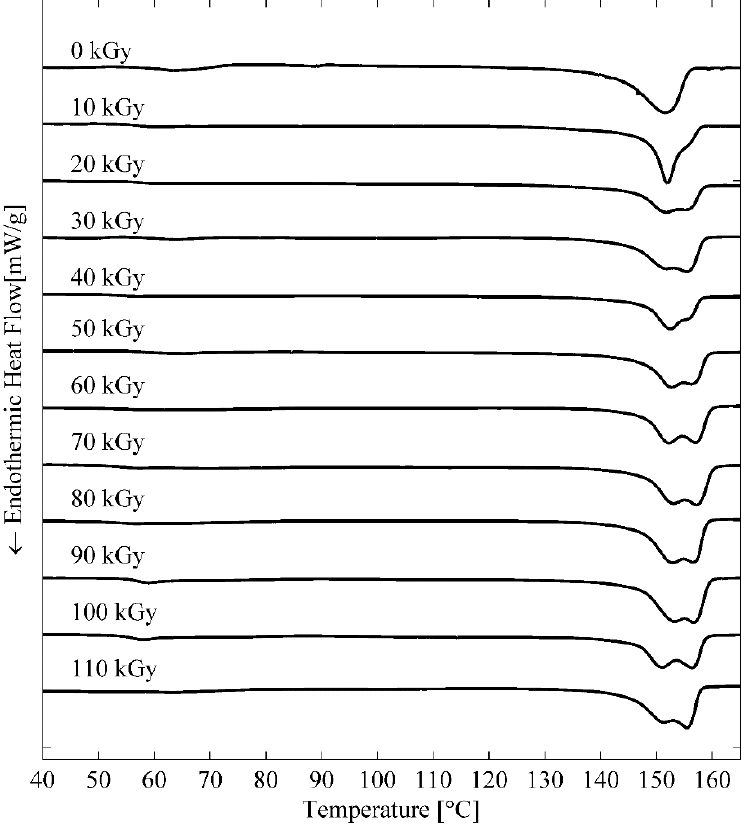
Figure 7. DSC results for irradiated 4043D resin from 10 to 110 kGy [13].